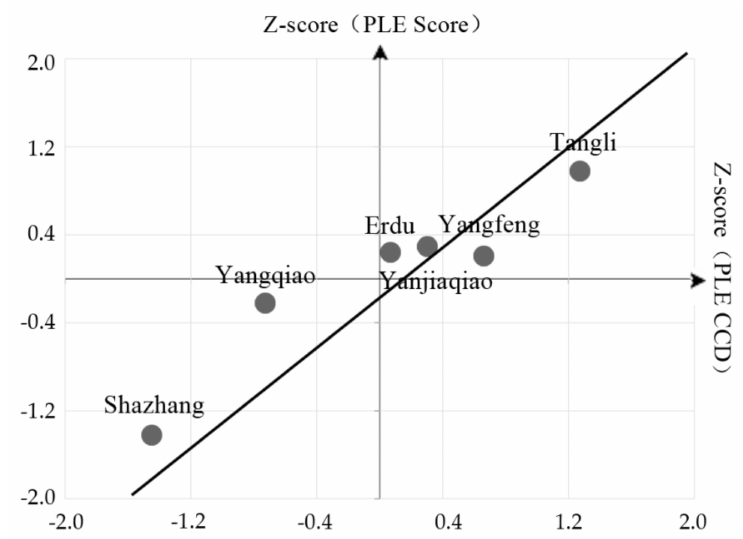
Figure 5. The relationship between PLE score with PLE CCD.